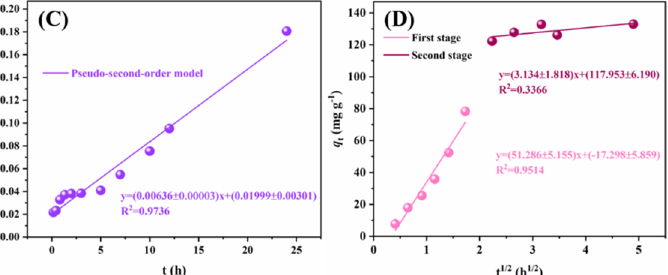
Figure 4. Adsorption of Pb 2+ by LDHs, MIL-88A(Fe), and MIL-88A-LDHs: ( A ) effect of contact time, ( B ) PFO, ( C ) PSO and ( D ) intra-particle diffusion model. Experimental conditions: [Pb 2+ ] = 53.15 mg L − 1 , initial pH = 3.0, adsorbent dose = 0.01 g, solution volume = 25 mL.